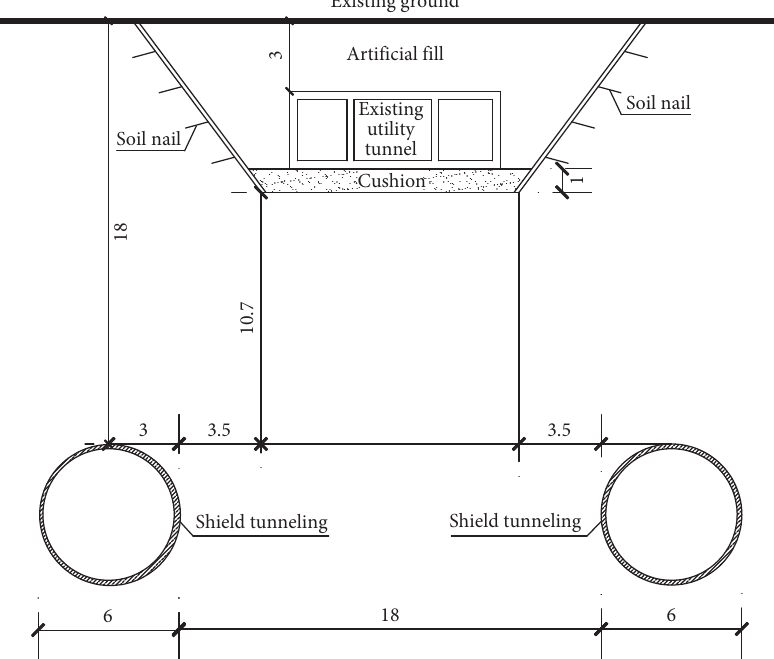
Figure 3: Sketch of relative position of the utility tunnel and metro tunnel (unit: m).